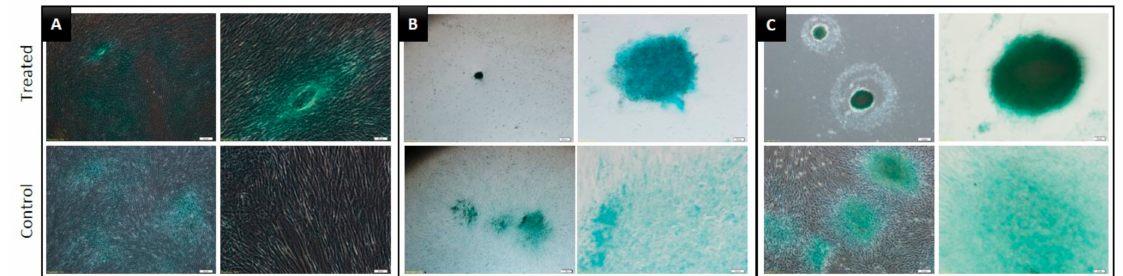
Figure 6. Images of DPSCs induced to undergo chondrogenic di ff erentiation for 14 days and stained with Alcian blue. ( A ) 2D, ( B ) SF, and ( C ) ULA group,